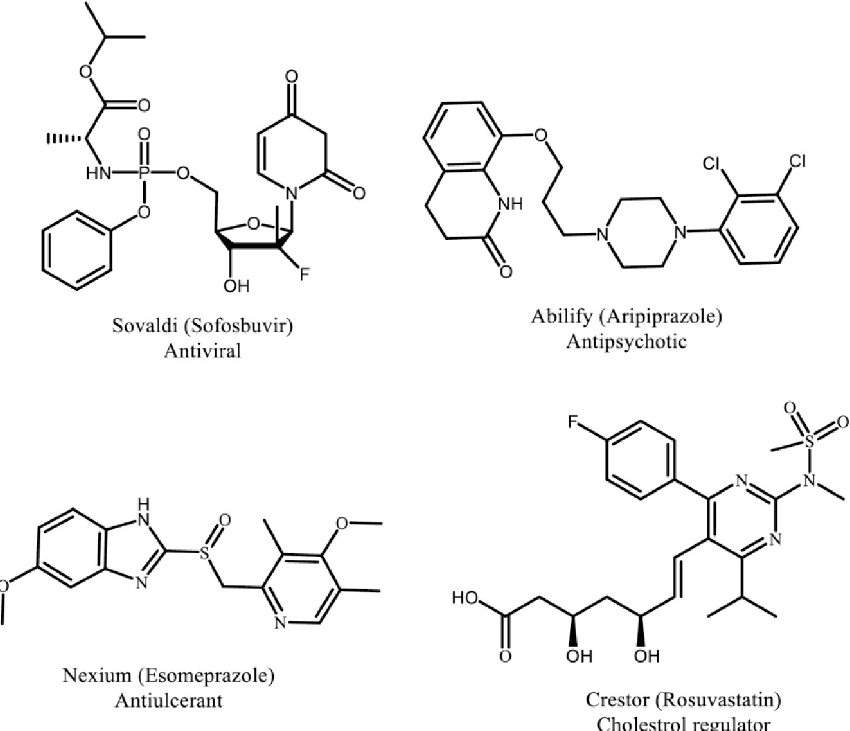
Fig 8. Marketed drugs with heterocyclic fragments in their structures. Different marketed drugs with heterocyclic pharmacophore that play crucial role in their physiochemical